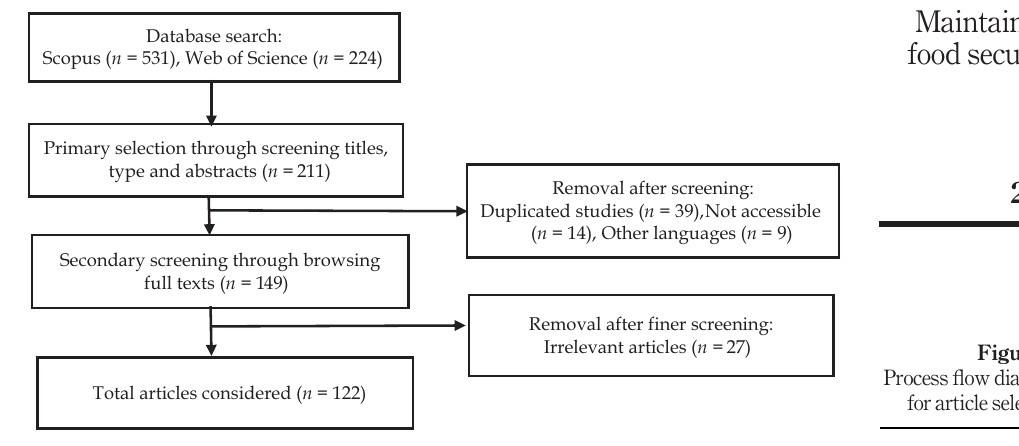
Figure 1. Process fl ow